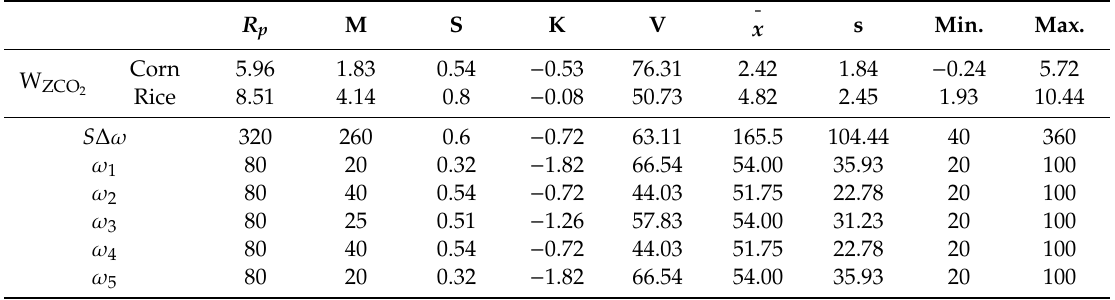
Table 7. Results of the basic statistical analysis for the sustainable CO 2 emissions index distribution. R p